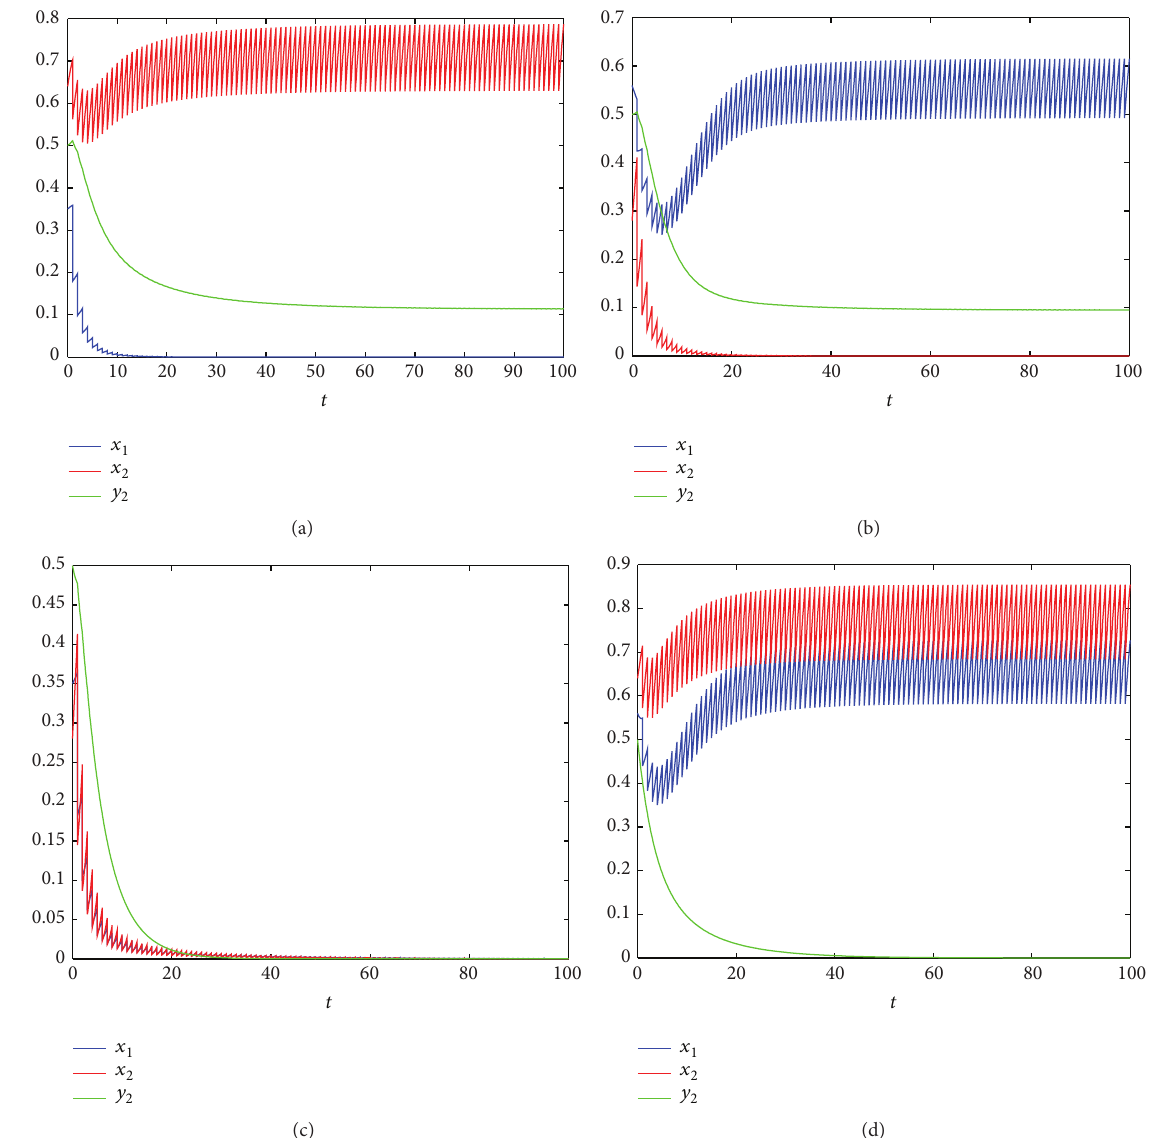
Figure 4: Dynamical behavior of system (3) with initial values 𝑥 1 (0) = 0.7 , 𝑥 2 (0) = 0.8 , and 𝑦 2 (0) = 0.5 . (a) Time series of 𝑥 1 , 𝑥 2 , and 𝑦 2 with 𝑝 1 = 0.5 , 𝑝 2 = 0.2 , which imply that overcatching of 𝑥 1 will drive it to die out. (b) Time series of 𝑥 1 , 𝑥 2 , and 𝑦 2 with 𝑝 1 = 0.2 , 𝑝 2 = 0.65 , which imply that overcatching of 𝑥 2 will also drive it to die out. (c) Time series of 𝑥 1 , 𝑥 2 , and 𝑦 2 with 𝑝 1 = 0.5 , 𝑝 2 = 0.65 . Figures show that the three species die out because of overcapturing of the two preys. (d) Time series of 𝑥 1 , 𝑥 2 , and 𝑦 2 with 𝜏 = 4 , the remaining parameters are as fixed as those in Figure 3. Comparing Figure 4 with Figure 3, one can find that the delay 𝜏 large enough can lead 𝑦 2 to die out.